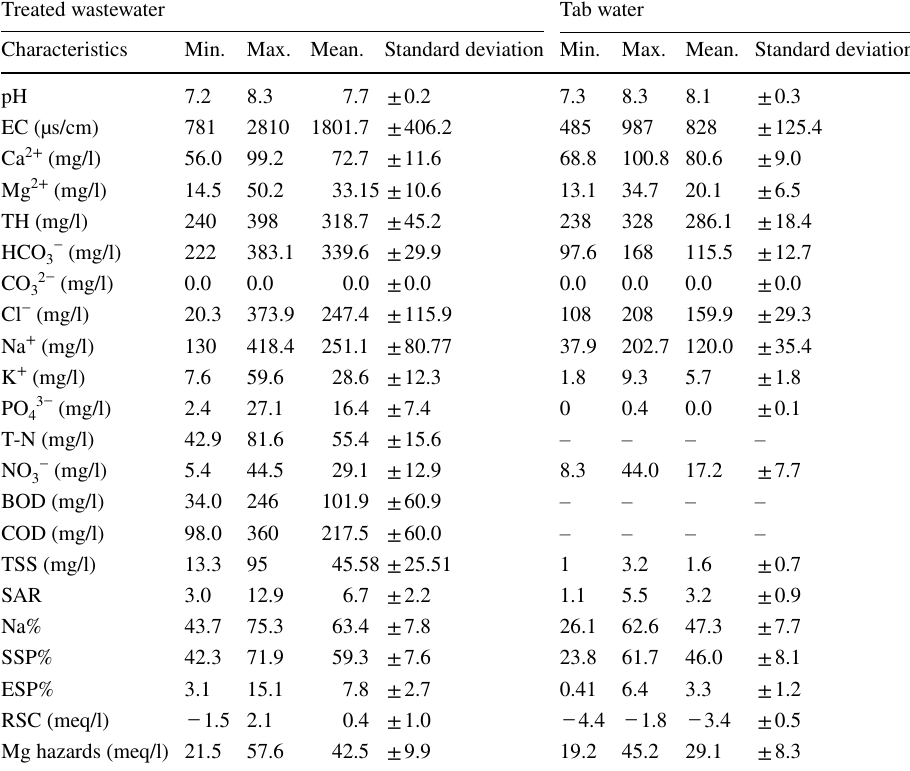
Treated wastewater